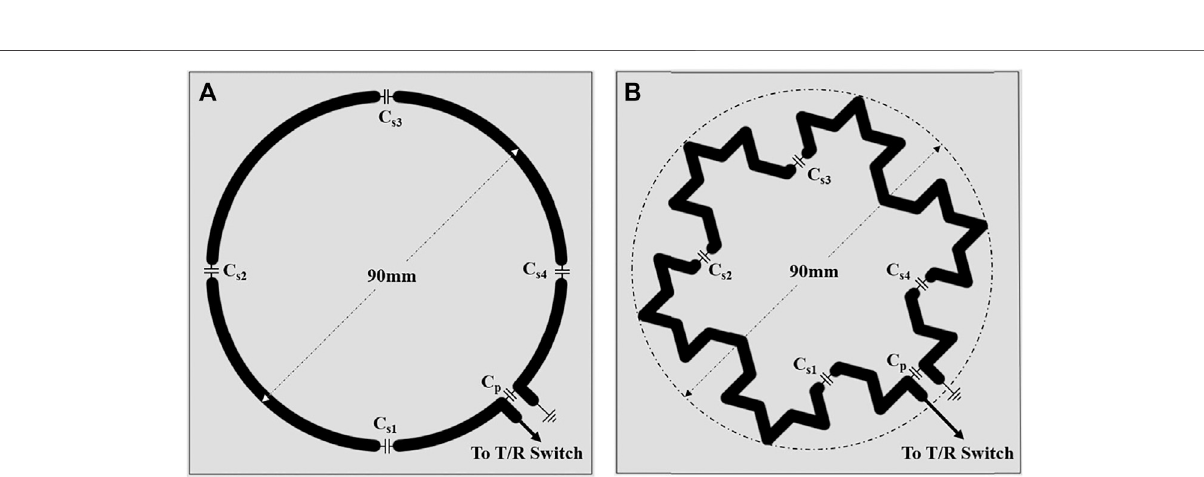
FIGURE1| The fi rstfourgenerationsofaKochsnow fl akefractalcomparedtoacircleofthesameradius(imagemodi fi edfromhttps://en.wikipedia.org/wiki/Koch_ snow fl ake, which is licensed for free use under: https://creativecommons.org/licenses/by-sa/3.0/deed.en).